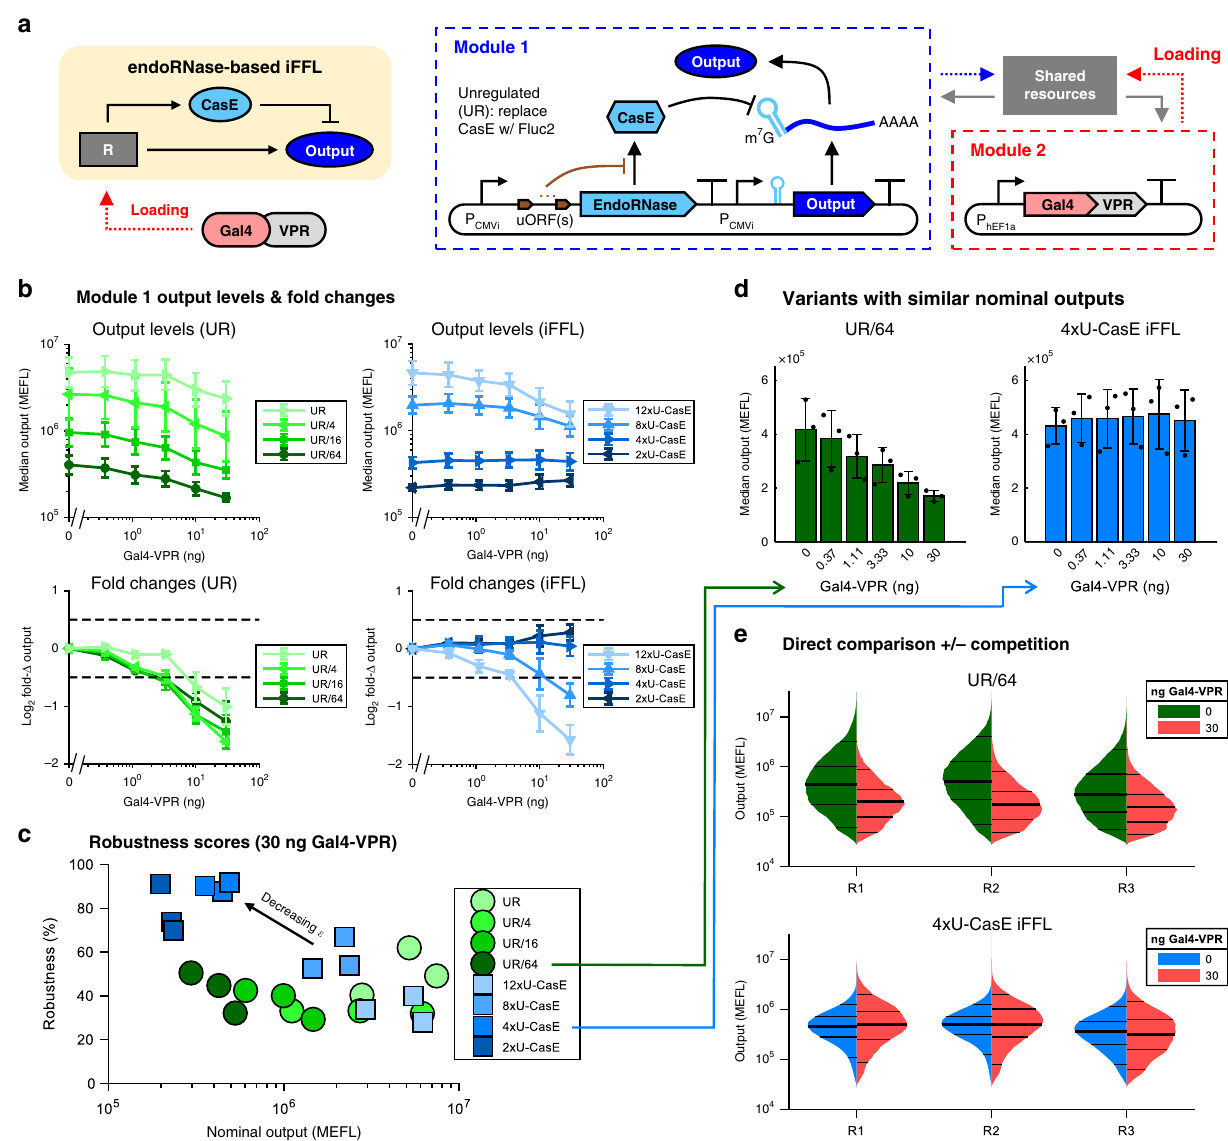
Fig. 4 Robustness of the iFFL output level to resource loading by Gal4-VPR. a Schematic and genetic diagram of the endoRNase-based iFFL module. 0-12 uORFs are placed in the 5 ′ UTR of CasE mRNA to reduce its translation rate ( ‘ #xU-CasE ’ : # ≡ number of uORFs). CasE binds and cleaves a speci fi c target site in the 5' UTR of the output mRNA. The unregulated (UR) version of Module 1 replaces CasE with Fluc2, has no uORFs, and retains the CasE target site in the output mRNA. Samples with reduced UR plasmid copy numbers ( ‘ UR/# ’ : # ≡ reduction factor) are provided to compare UR and iFFL variants with similar output levels. The output reporter is EYFP; not shown are two constitutive reporters (CMVi:TagBFP, hEF1a:mKO2). b Response of iFFL module to resource (cid:2) σ loading by Gal4-VPR. The top plots show the mean ( μ ) ± relative error ( 1 μ ) of median output levels. The relative error is used to more accurately ln ð 10 Þ represent error on the log-scale 76 . The bottom plots show the mean± s.d. of fold changes (fold- Δ s). Fold- Δ s are computed by dividing the median level of output at a given dosage of Gal4-VPR by that at 0 ng Gal4-VPR (i.e. the nominal output level — see Eq. (6) in “ Methods ” ). Data are from three experimental repeats. c Robustness scores (100% minus % deviation from the nominal level — see Eq. (8) in “ Methods ” ) computed for each UR and iFFL variant at 30 ng Gal4-VPR. Symbols represent measurements from each experimental repeat. d Direct comparison of UR and iFFL variants with similar nominal outputs. Error bars represent the mean±s.d. of measurements from three experimental repeats. e Distributions of output levels per cell at 0 and 30 ng Gal4-VPR for the UR and iFFL variants shown in panel ( d ), for all three experimental repeats (R#). The lines on the histograms denote the 5th, 25th, 50th, 75th, and 95th percentiles. All data were measured by fl ow cytometry at 72h post transfection in HEK-293FT cells. All measurements were made on cells gated positive for output. Measurements on cells gated positive for either output or TX marker are shown in Supplementary Fig. 19. iFFL samples with 0 or 1 uORFs are not shown because most or all of the cells in those samples did not express output above the auto fl uorescence background and their median expression levels were much lower than that of any UR variants. Median values for each sample and the number of cells plotted per histogram are provided in Source bins to the fi t value of the iFFL model parameter Y (Supple- (and thus increasing the output level) decreases the range of DNA max copy numbers over which the iFFL output adapts to DNA copy mentary Fig. 36b). We considered a bin to be adapted to DNA number variation (Fig. 6c). We repeated these experiments and copy number variation if log 10 (output) was within 5% of analyses with the CMVi-driven CasE iFFL and found similar log 10 ( Y ) (i.e., the log-scale robustness score was above 95%). max results (Supplementary Fig. 37). As predicted from the model, increasing the number of uORFs